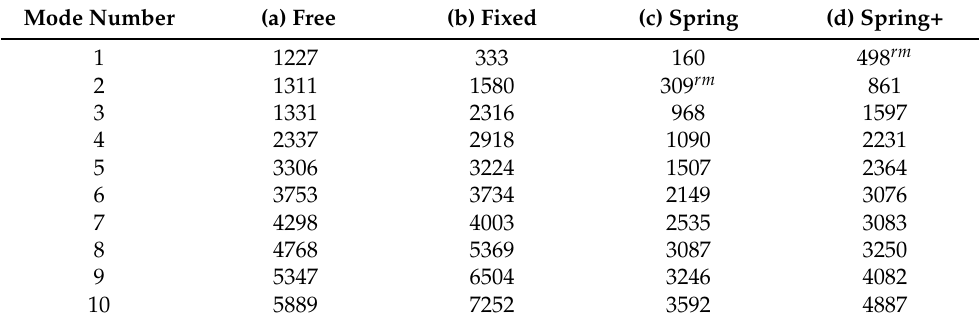
Figure 5. Modal frequencies as a function of the mode number, from Tables 2 and 3. Note that in this case, eigenfrequencies are rearranged in order to take care of mode switches. Each plot compares the values obtained for the Normal model and Model 30 in a specific boundary condition. ( a ) Free boundary conditions. ( b ) Fixed boundary conditions. ( c ) Boundary condition with springs at the feet only. ( d ) Boundary condition with both springs at the feet and at the upper arch. Table 2. Values of the first 10 natural frequencies (in Hz ) of the Normal Model in different boundary conditions. Case (c) only includes springs at the feet, while case (d) both springs at the feet and at the upper arch. Modes where the bridge moves rigidly are denoted with rm . All mode shapes are available in Figures A2, A4, A6, and A8.